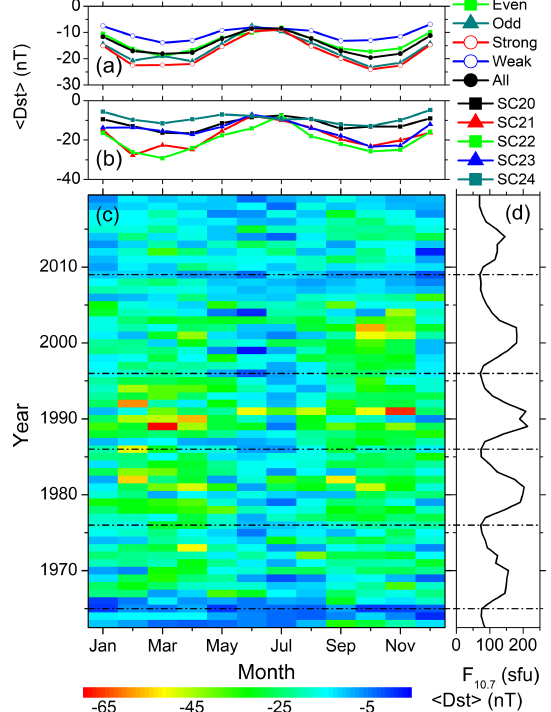
Figure 6. Intense geomagnetic storms from 1963 to 2019. The pan- els are in the same format as in Fig. 4.